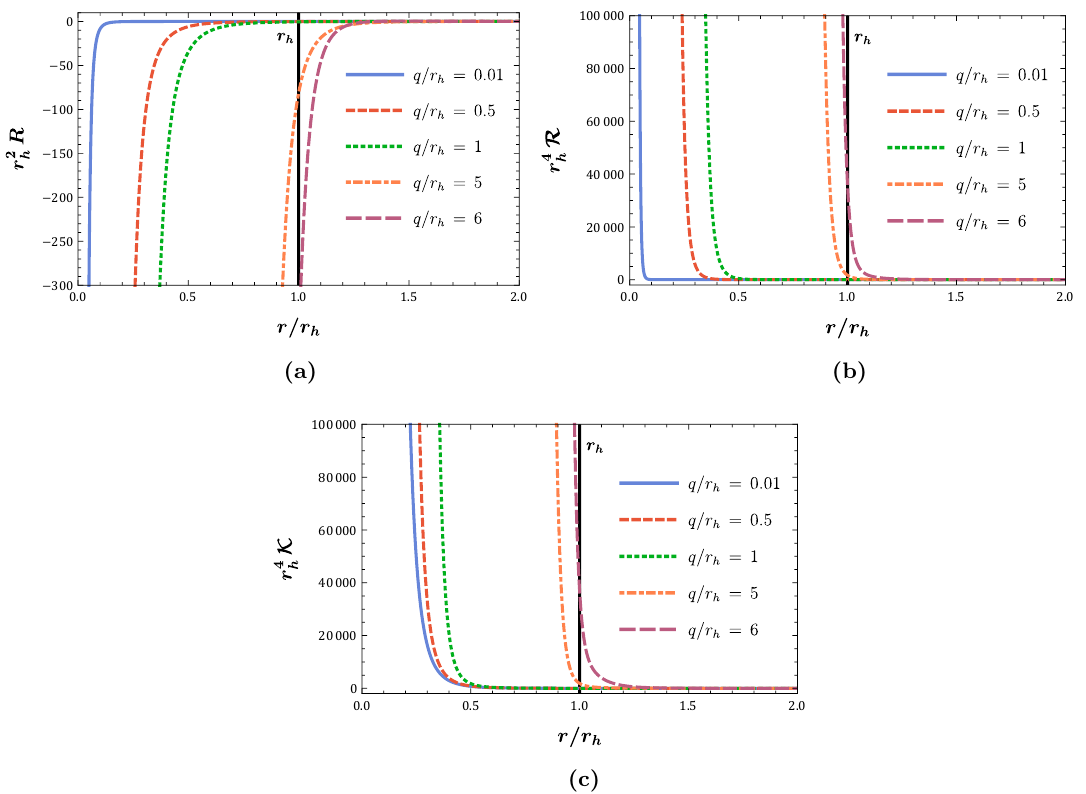
Figure 3. (a) The Ricci scalar r 2 in terms of the radial coordinate r for various values of the dimensionless parameter q/r quantity q/r takes the values 0 . 01 , 0 . 5 , 1 , 5 , 6 (from left to h